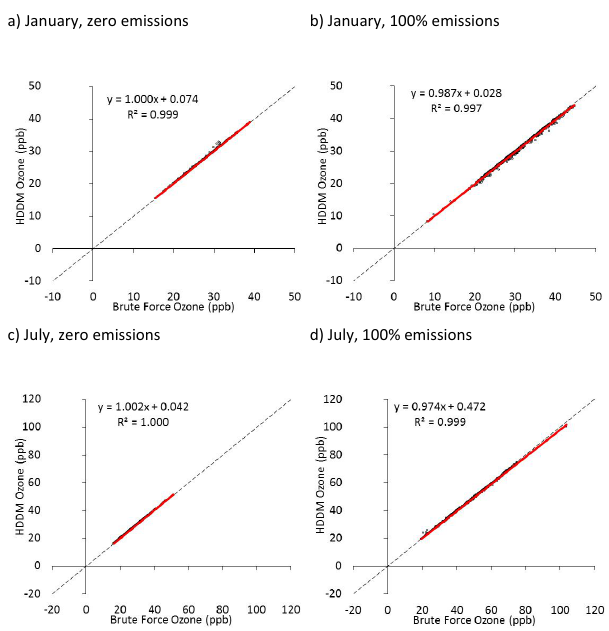
Fig. 8. Same as Fig. 6 but for the rural Weatherford location.